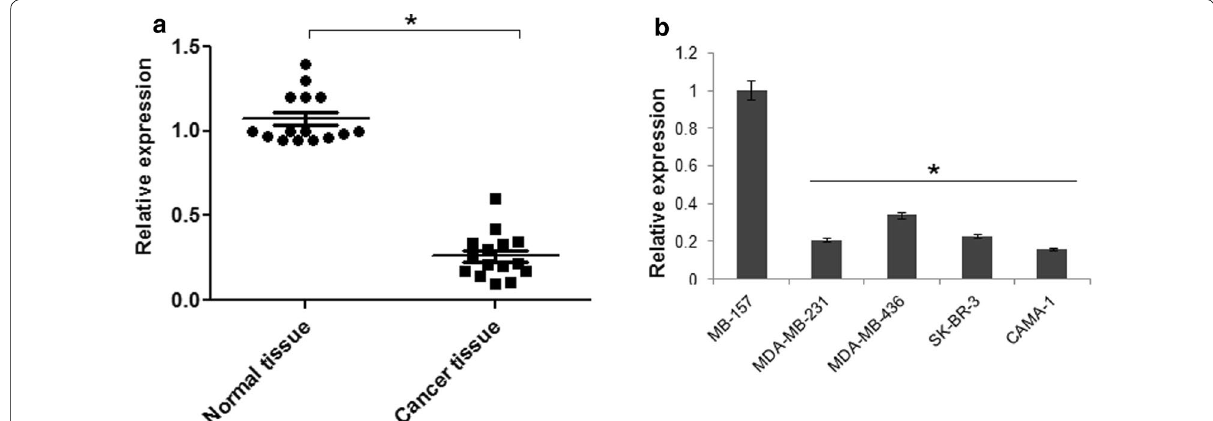
Fig. 1 Expression of miR-143 in ( a ) normal and cancer tissues ( b ) normal and breast cancer cell lines. The experiments were performed in triplicate and expressed as mean SD (*P < ±